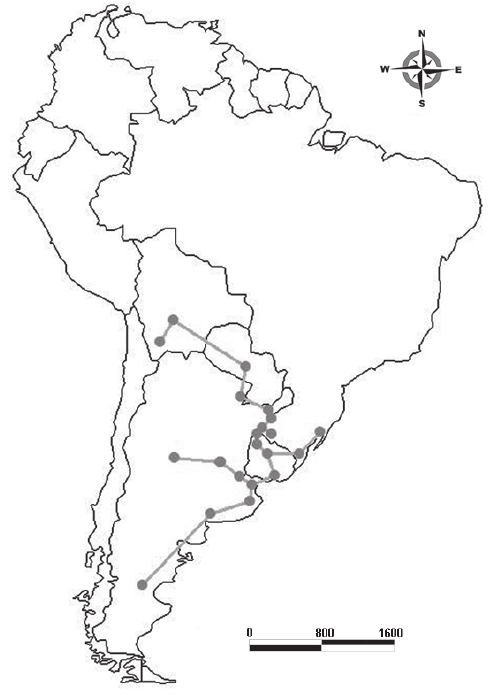
Fig. 5 - Individual track of Glyptodon clavipes .